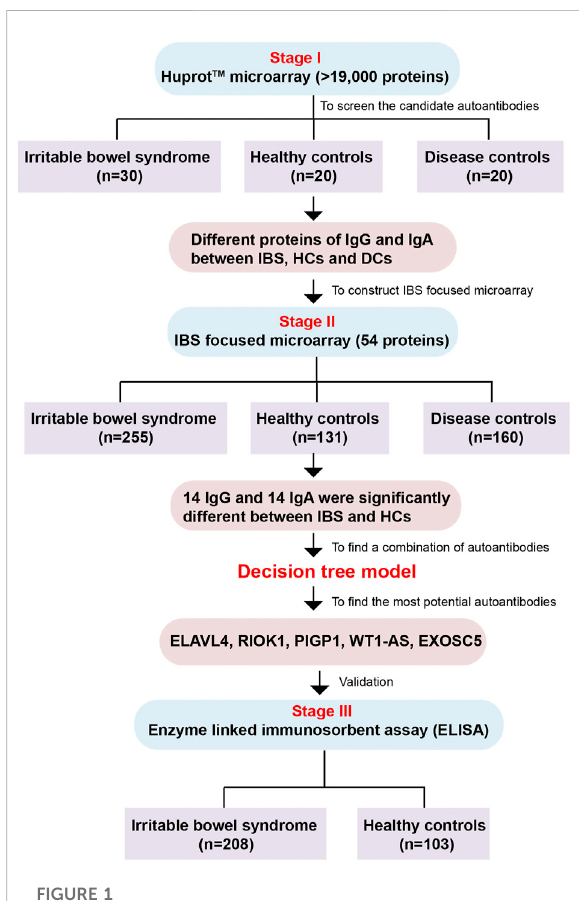
FIGURE 1 The fl ow chart of the whole study. The study is comprised of three stages including Huprot ™ human proteome microarray screening, IBS focused microarray test and ELISA validation. IBS, irritablebowelsyndrome;HCs,healthycontrols;DCs,disease